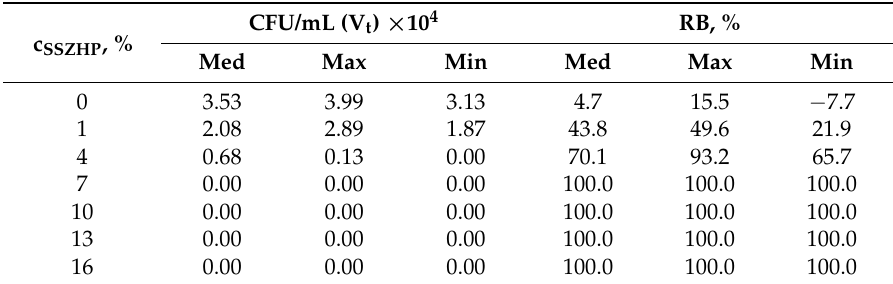
Table 2. The reduction in the number of viable colonies (RB) of Streptococcus mutans ATCC 33535, after 17 h of incubation with composites samples.